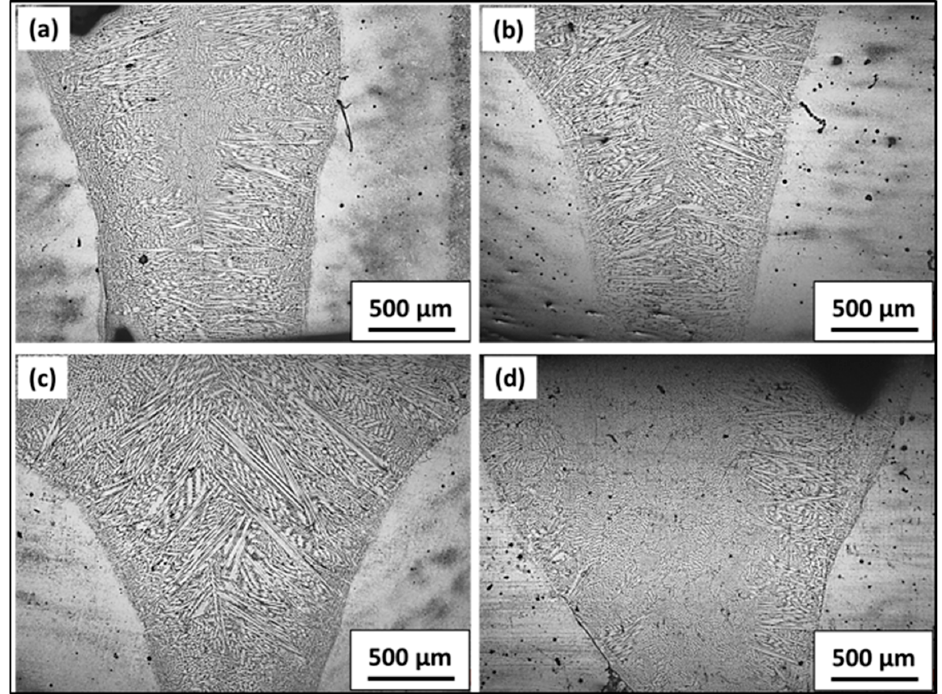
Figure 5. Optical images for different welding conditions at 20× magnification and 5× magnification at the top right corner. ( a ) S1000V60I35 OD 2 mm, ( b ) S1000V60I35 OD 0.5 mm, ( c ) S1000V60I35 WO and ( d ) S1200V60I35 WO.